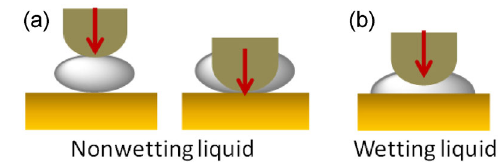
Fig. 2 Stability of liquid upon increasing load. Liquids are prone to be squeezed out of the contact area of sliding, leading to dry friction. Good wetting ability is required to form a stable lubricating film.